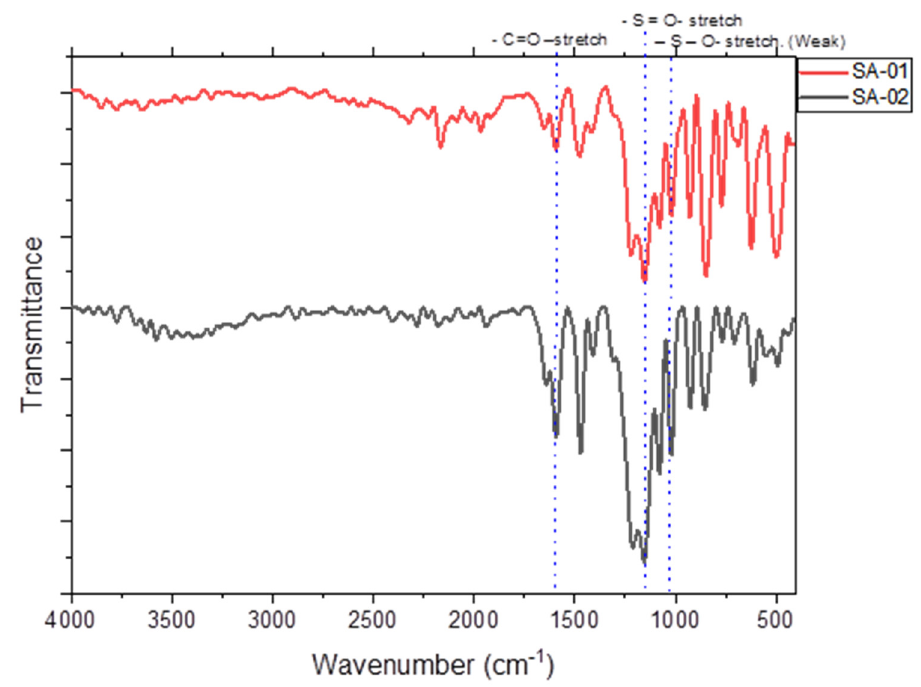
Figure 3. FTIR spectra of sulfonated PEEK samples, SA-01 (red), and SA-02 (black).